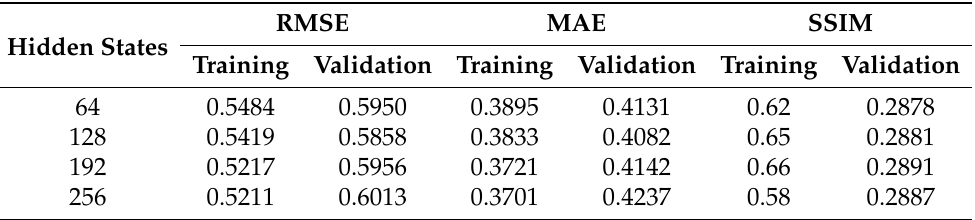
Table 4. Comparison of models with different hidden states over 24 prediction steps.